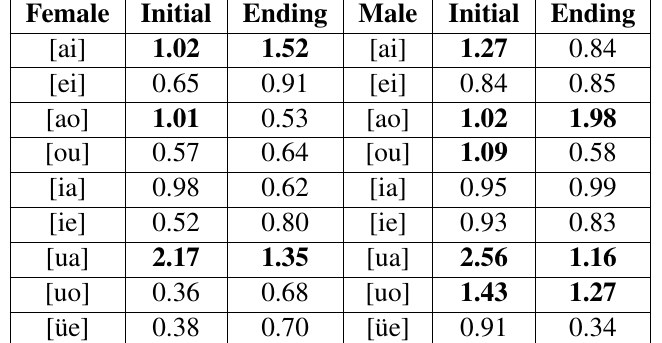
Table 4 Euclidean distance between advanced level learners and standard